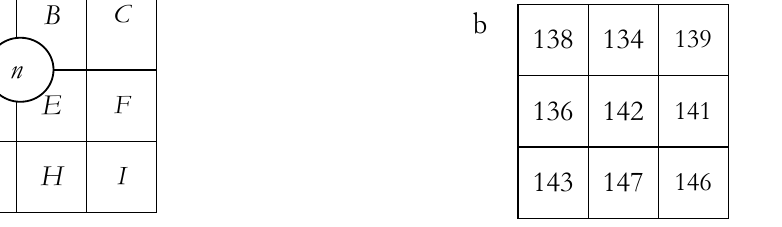
Figure 3. Grid consisting of nine cells and the corresponding elevations.